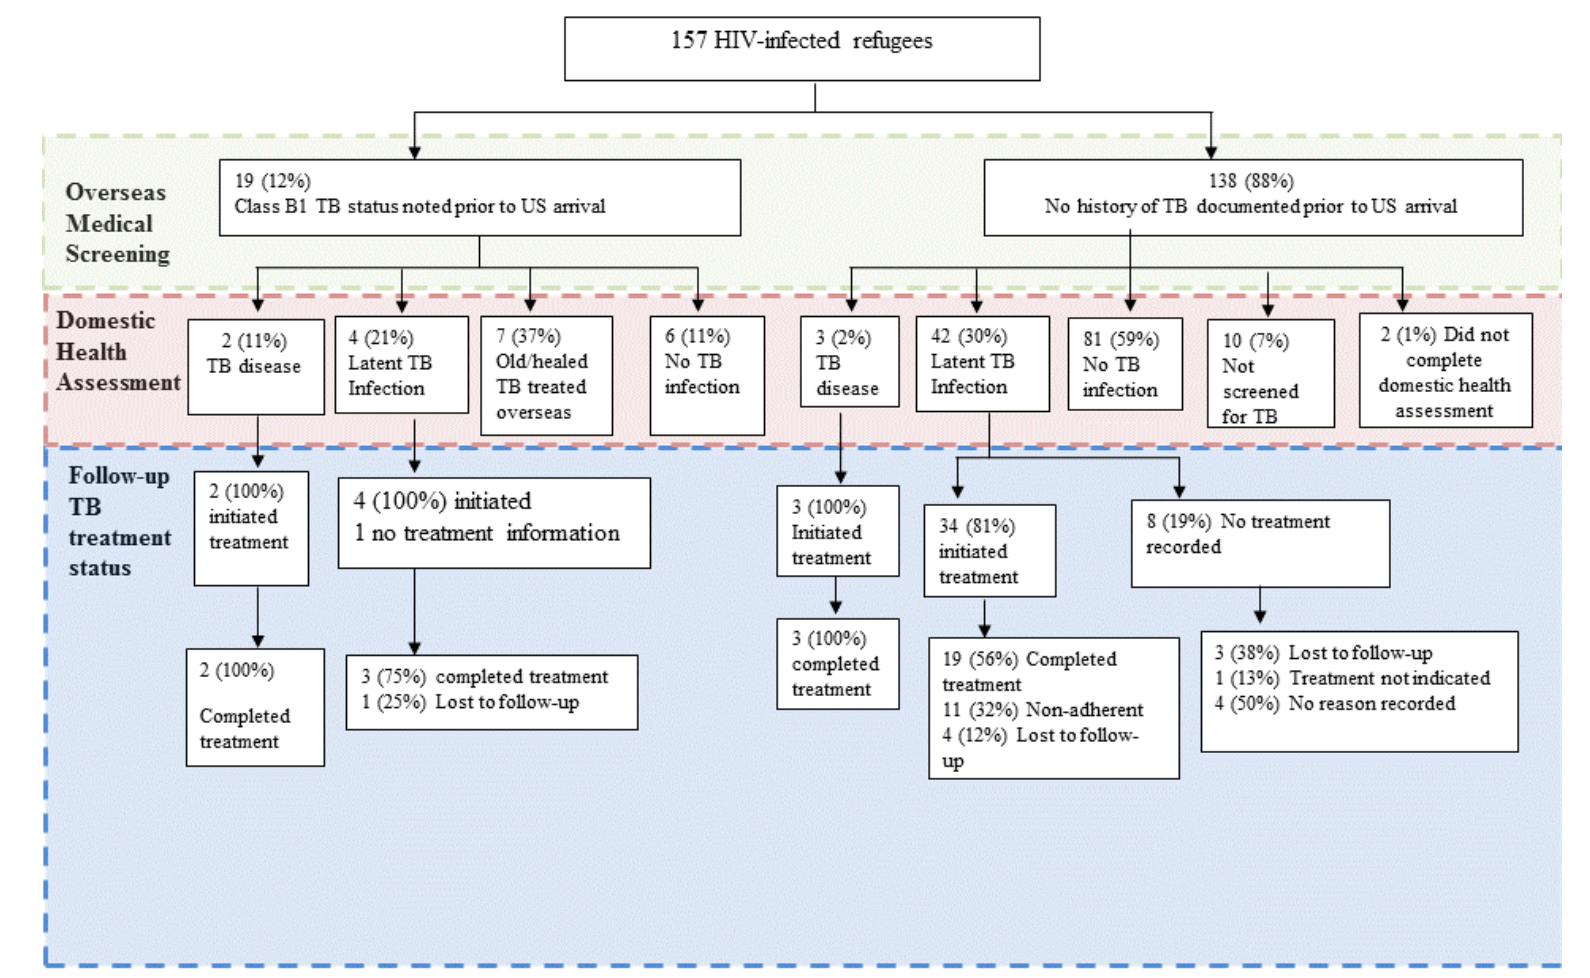
Figure 2. Tuberculosis (TB) Diagnosis and Treatment Status Among HIV-Infected Refugees Resettled to Minnesota,